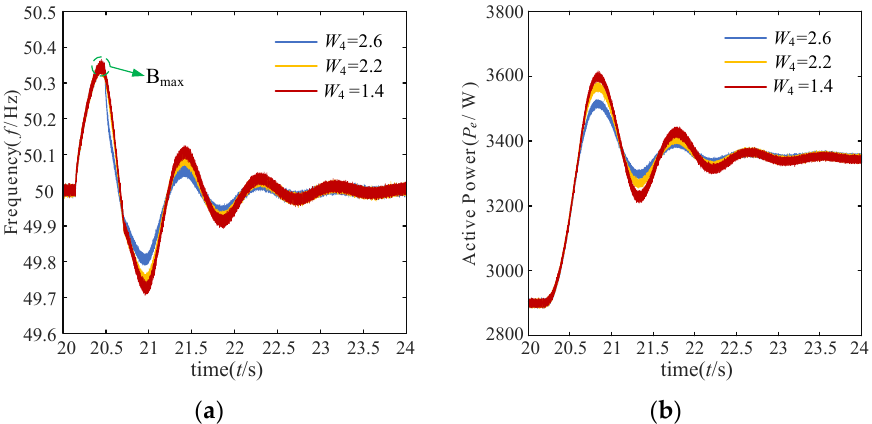
Figure 15. The influence of control parameter W 4 variations on the system: ( a ) System frequency waveforms; ( b ) Output waveforms active power.